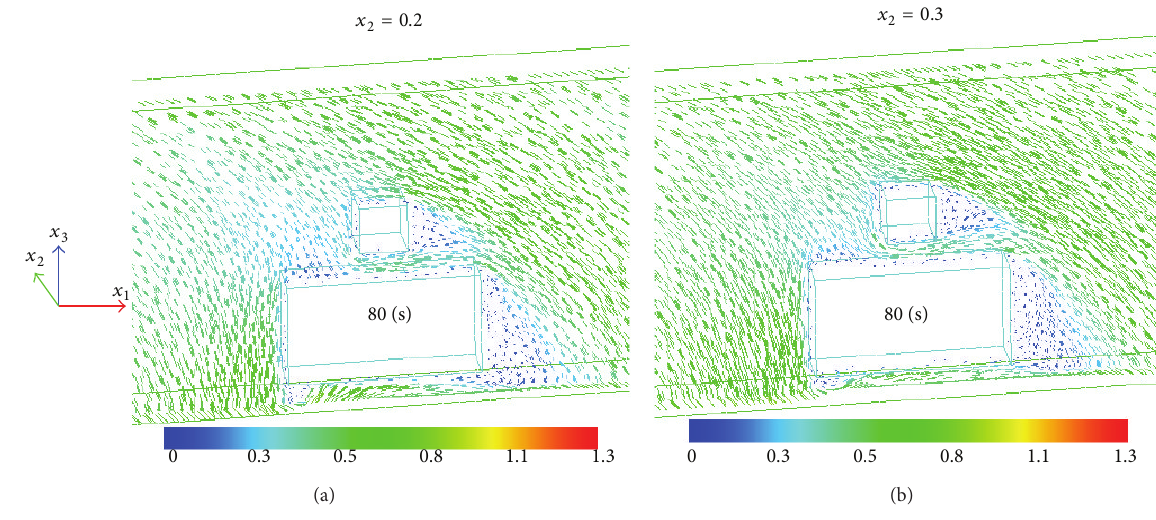
Figure 10: Velocity vectors around 3D AGV model.